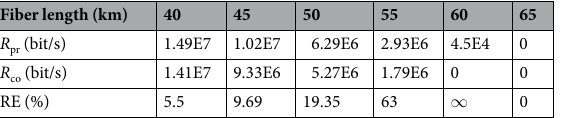
Table 3. Secret key rate of the proposed and conventional methods for N = 12 and M = 1 at different fiber